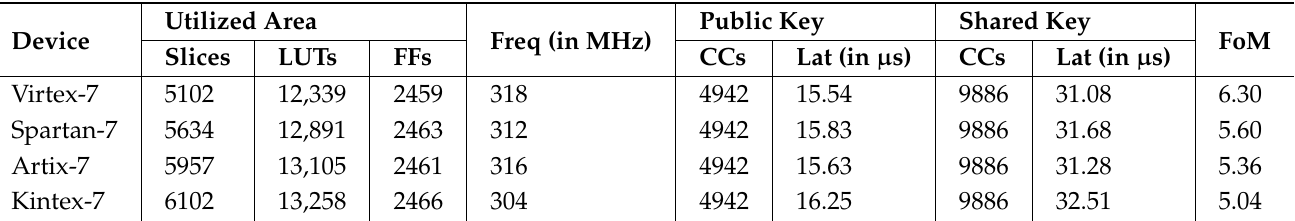
Table 2. Implementation results after place-and-route over GF ( 2 233 ) on different FPGA